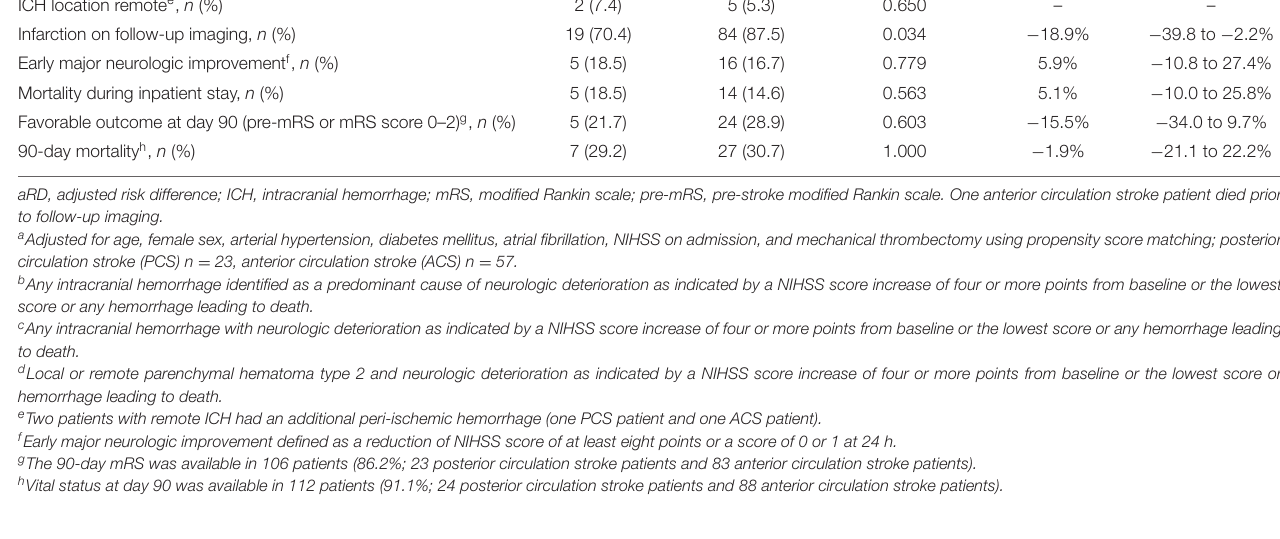
p -value aRD a 95% Posterior Anterior circulation circulation stroke ( n = 27) stroke ( n = 96)